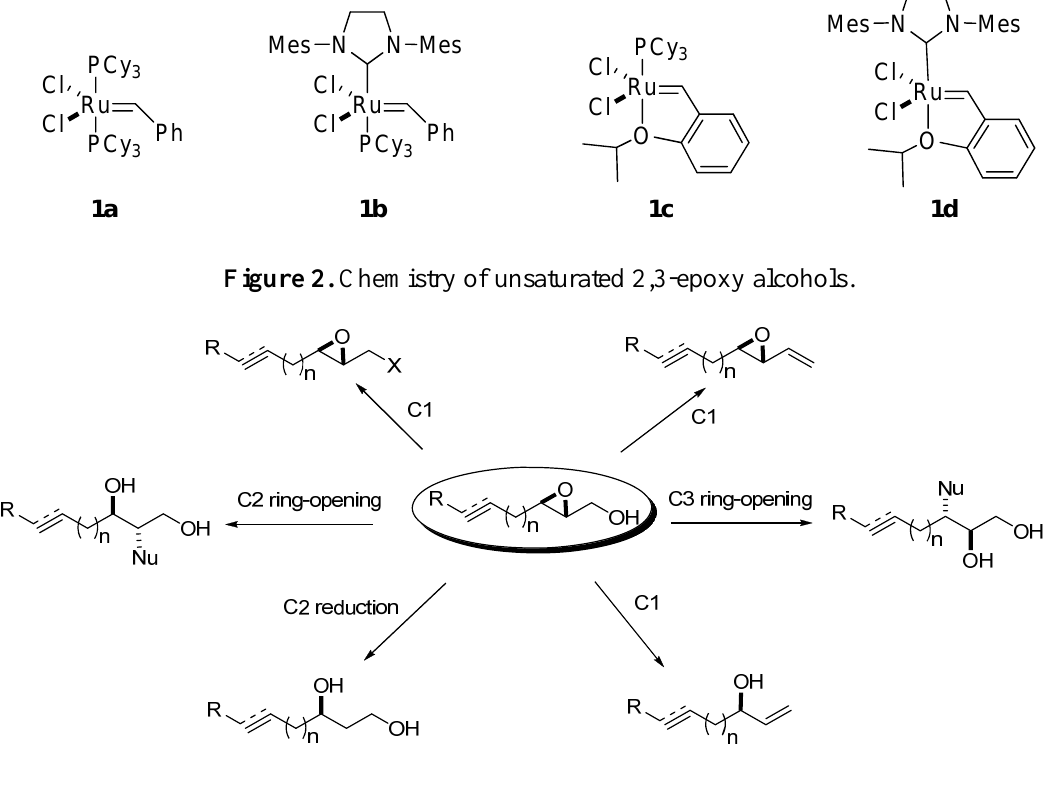
Figure 1. Ruthenium catalysts for metatheses: first-generation Grubbs’ catalyst ( 1a ); second- generation Grubbs’ catalyst ( 1b ); first-generation Hoveyda-Grubbs’ catalyst ( 1c ); and second-generation Hoveyda-Grubbs’ catalyst ( 1d ).